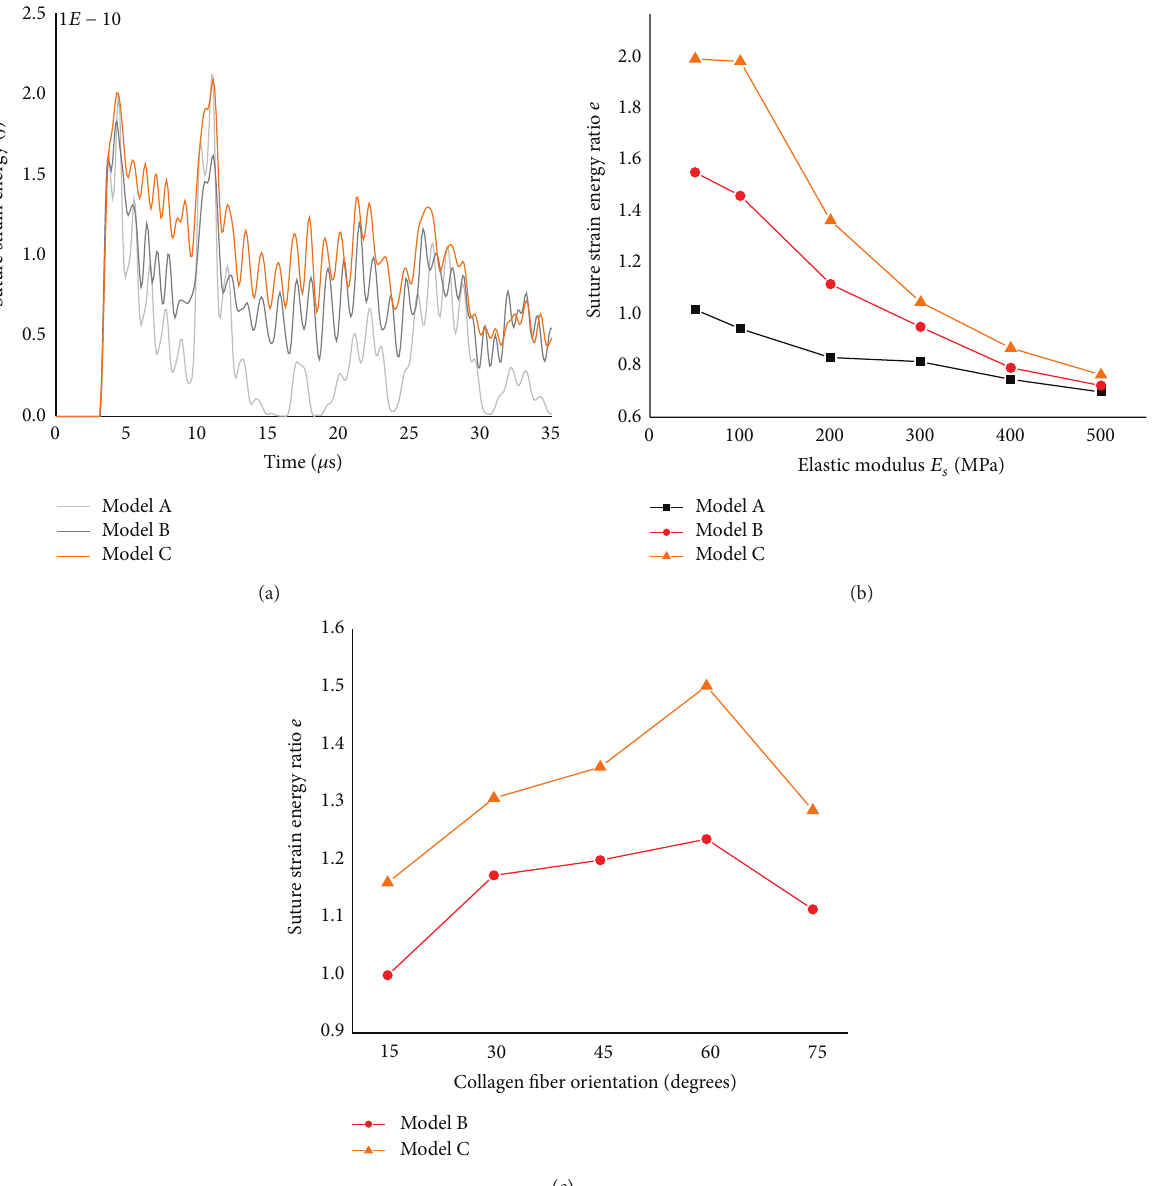
that an optimal fiber arrangement would make the suture better to withstand both tension-compression loading and shear loading, imparting a greater potential for storing energy. This would be inconsistent with the findings of the interdigitated bone suture under a static loading